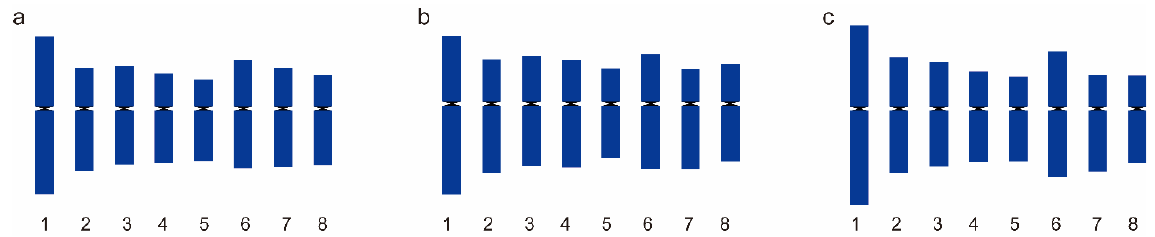
Figure 8. Ideogram of the karyotypes of P. pseudocerasus _HC ( a ), P. avium _Mazzard ( b ), and P. per- sica _MT ( c ). Chromosome nomenclature according to the genome P. persica .